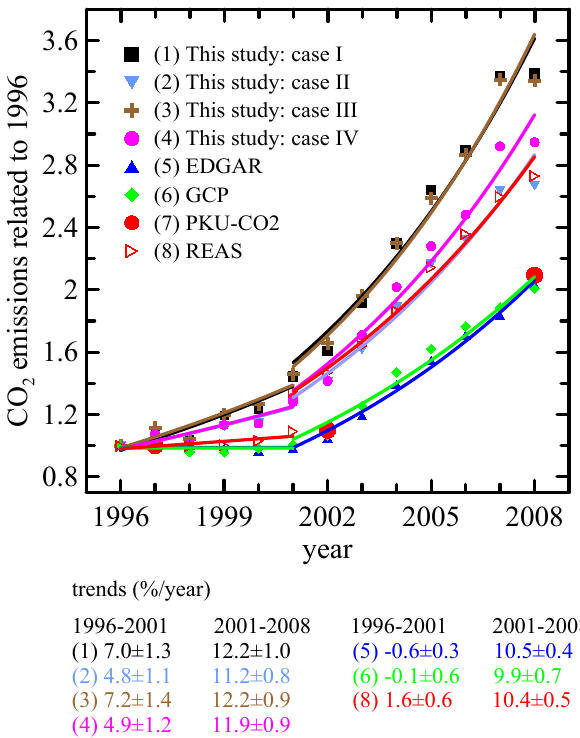
Fig. 4. Multiannual exponential total anthropogenic CO 2 emission trends in China derived from satellite measurements and calculated with the EDGAR v4.2, GCP, and REAS (v1.11 and v2.1) data for the periods from 1996 to 2001 and from 2001 to 2008. Note that the REAS v1.11 and v2.1 data are shown for the abovementioned periods, respectively. Additionally, the PKU-CO2 data are shown for three years (1997, 2002, and 2008). All the data are normalized to the values from 1996. Note that only relative changes (not abso- lute values) of emissions are evaluated in this study; thus the dif- ferences between the top-down and bottom-up emission estimates cannot be unambiguously attributed to certain